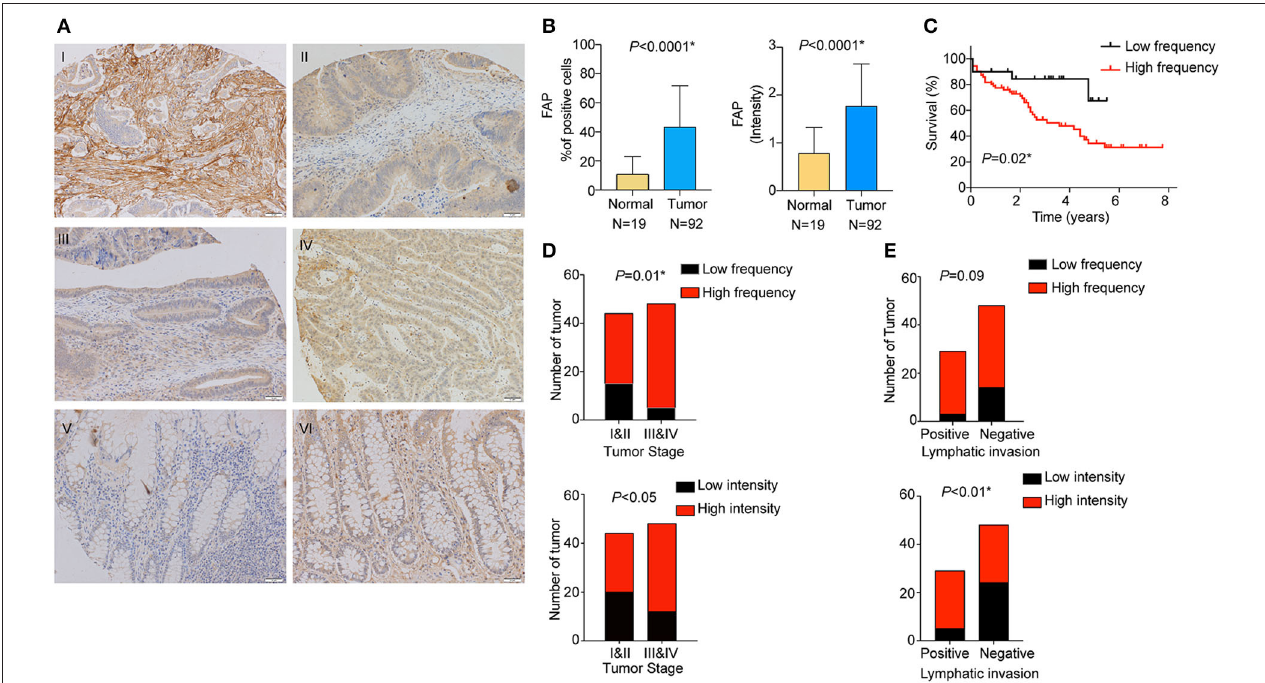
FIGURE 1 | FAP protein is overexpressed in CRC and is associated with worse overall survival. (A) Representative examples of FAP expression by immunohistochemistry. FAP expression in (I) high percentage of tumor-associated stromal cells ( 100% ); (II) tumor-associated stroma with low number of positive cells (5% ); (III) normal tissue showing negative staining for FAP; (IV) FAP high-intensity staining in tumor-associated stromal cells ( high ); (V) FAP low-intensity staining in tumor-associated stromal cells ( low ); and (VI) normal tissue showing FAP high-intensity staining in stroma cells. Scale bar: 50 µ m. (B) Percentage of cells showing positive FAP staining in normal stroma and tumor-associated stroma (above). Scoring of FAP staining based on intensity in normal and tumor-associated stroma (below). (C) Overall survival analysis (Kaplan–Meier) of CRC patients from the TMA cohort after stratification for high and low percentage of FAP-positive cells. Number of CRCs with high and low percentages of FAP-positive cells (above), as well as high and low FAP intensity (below) in (D) early and advanced tumor stages, and (E) positive and negative lymphatic invasion. Statistical analyses were performed using Fisher exact test for categorical variables, Mann–Whitney U -test for numeric variables and log-rank (Mantel–Cox) test for survival analysis. All tests were two-sided, and p < 0.05 was considered statistically significant. Data in (B) are represented as mean ± SD. *Statistical power > 70%.